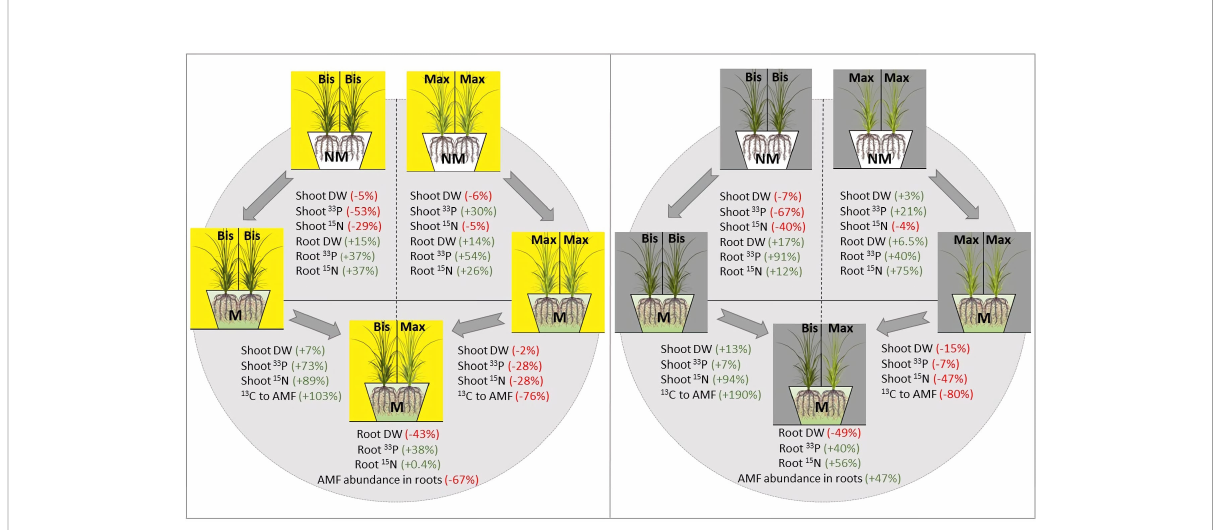
FIGURE 6 Summarization of changes in shoot and root dry biomass, 33 P and, 15 N resource uptake into above- and belowground plant tissues in mycorrhizal and non-mycorrhizal P.bisulcatum (Bis) and P.maximum (Max) as well as 13 C allocation to AM fungi and abundance of mycorrhizal fungi in roots under full light and full shade regimes, from mono- to mixed-systems. “ M ” and “ NM ” refer to mycorrhizal and non-mycorrhizal status, respectively. Arrows indicate changes from one condition to another conditions. The values calculated for the transition from mono- to mixed systems are based on a theoretical model prediction, using the mono system as a baseline, and calculated response values from mono- to mixed-systems. AM fungal abundance in the roots is based on qPCR quanti fi cation of the AM fungal DNA in roots, whereas the 13 C allocation to AM fungi is based on the fatty acid analyses in